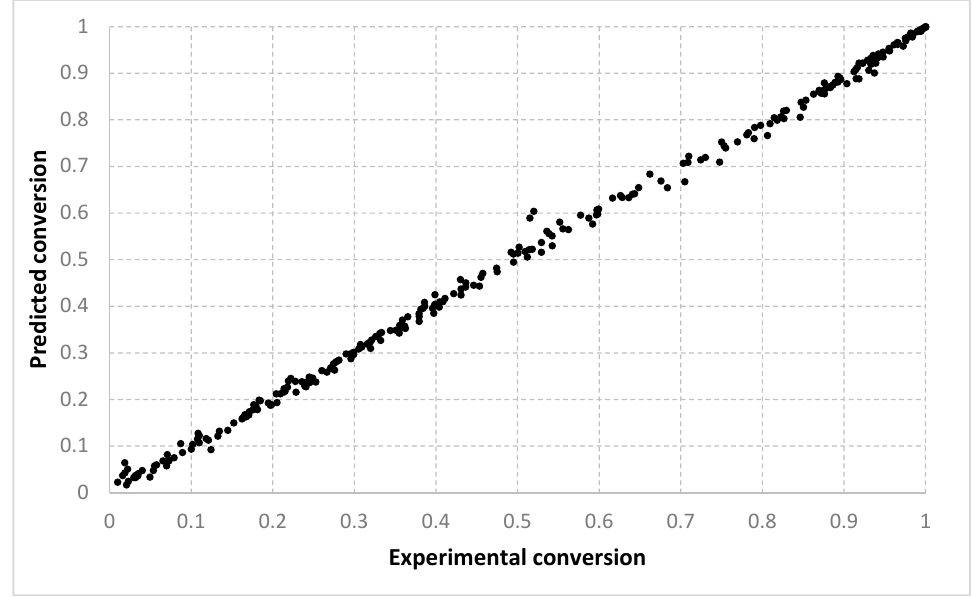
Figure 7. Predicted conversion with the LMNNR-AGD algorithm versus experimental conversion, setting 2, with data split into 67% for training and 33% for testing.